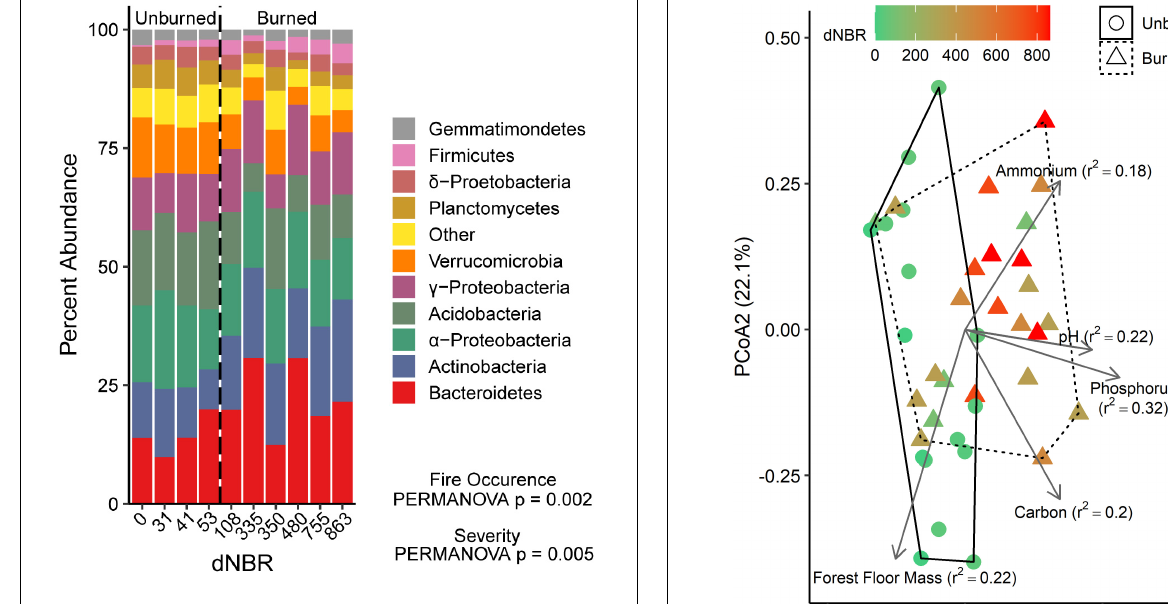
FIGURE 4 | Relative abundance of the ten most abundant bacterial phyla across a gradient of burn severity in mineral soils (0–5 cm). The ten most abundant phyla accounted for ∼ 94% of the total bacterial community. Abundances at each dNBR level are the means of four subplots.